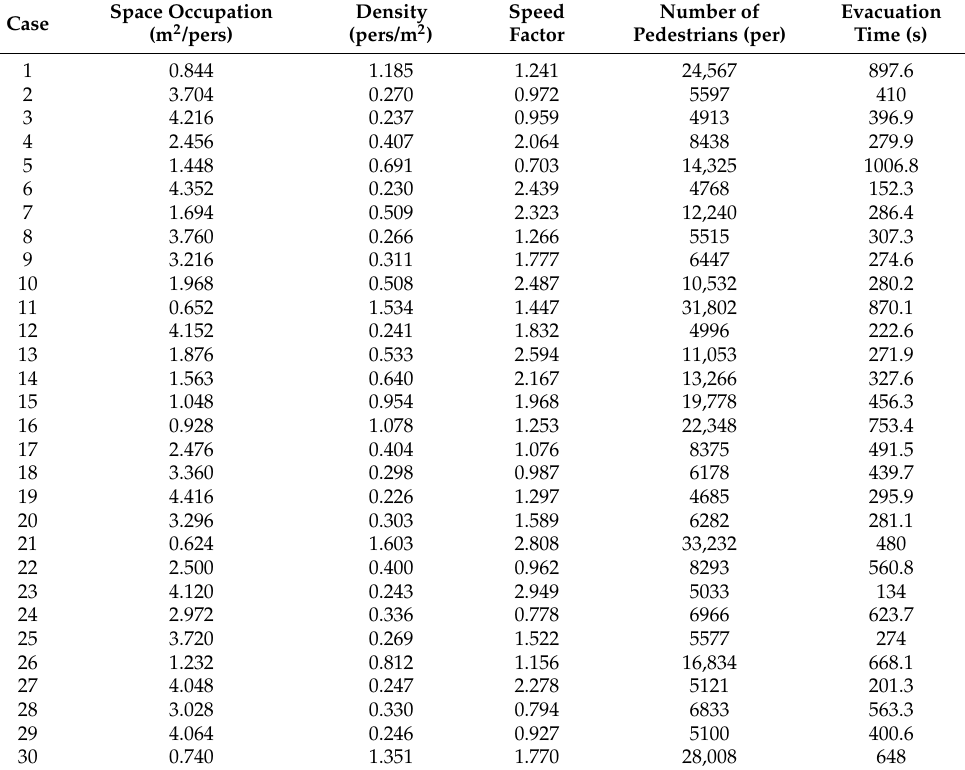
Table 3. Sample data and escape time randomly selected based on the Monte Carlo method.